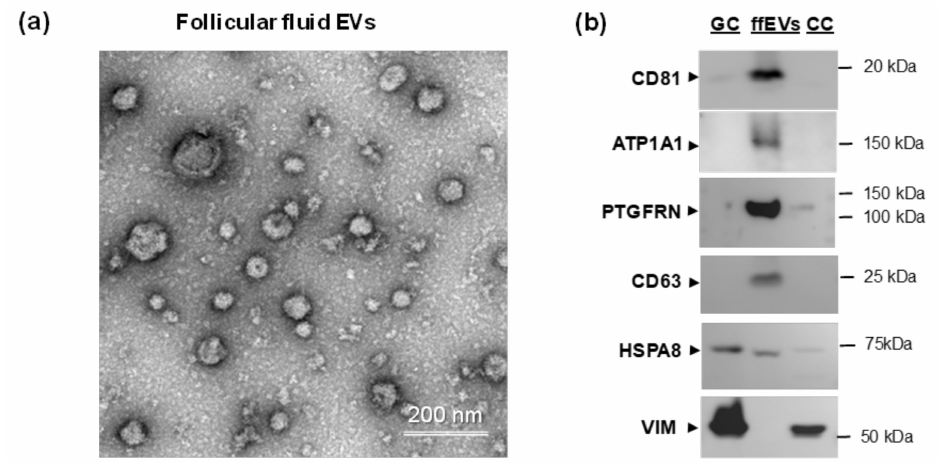
Figure 3. Analysis of potential palmitoyl-proteins in follicular granulosa cells (GC), cumulus cells (CC) and small extracellular vesicles extracted from follicular fluid (ffEVs). ( a ) Representative transmission electron microscopy images of ffEVs. ( b ) Western blot analysis of CD81, ATP1A1, VIM and PTGFRN in bovine GC, CC and ffEVs. Tetraspanin CD63 and heat shock protein A8 (HSPA8) were used as known EV markers